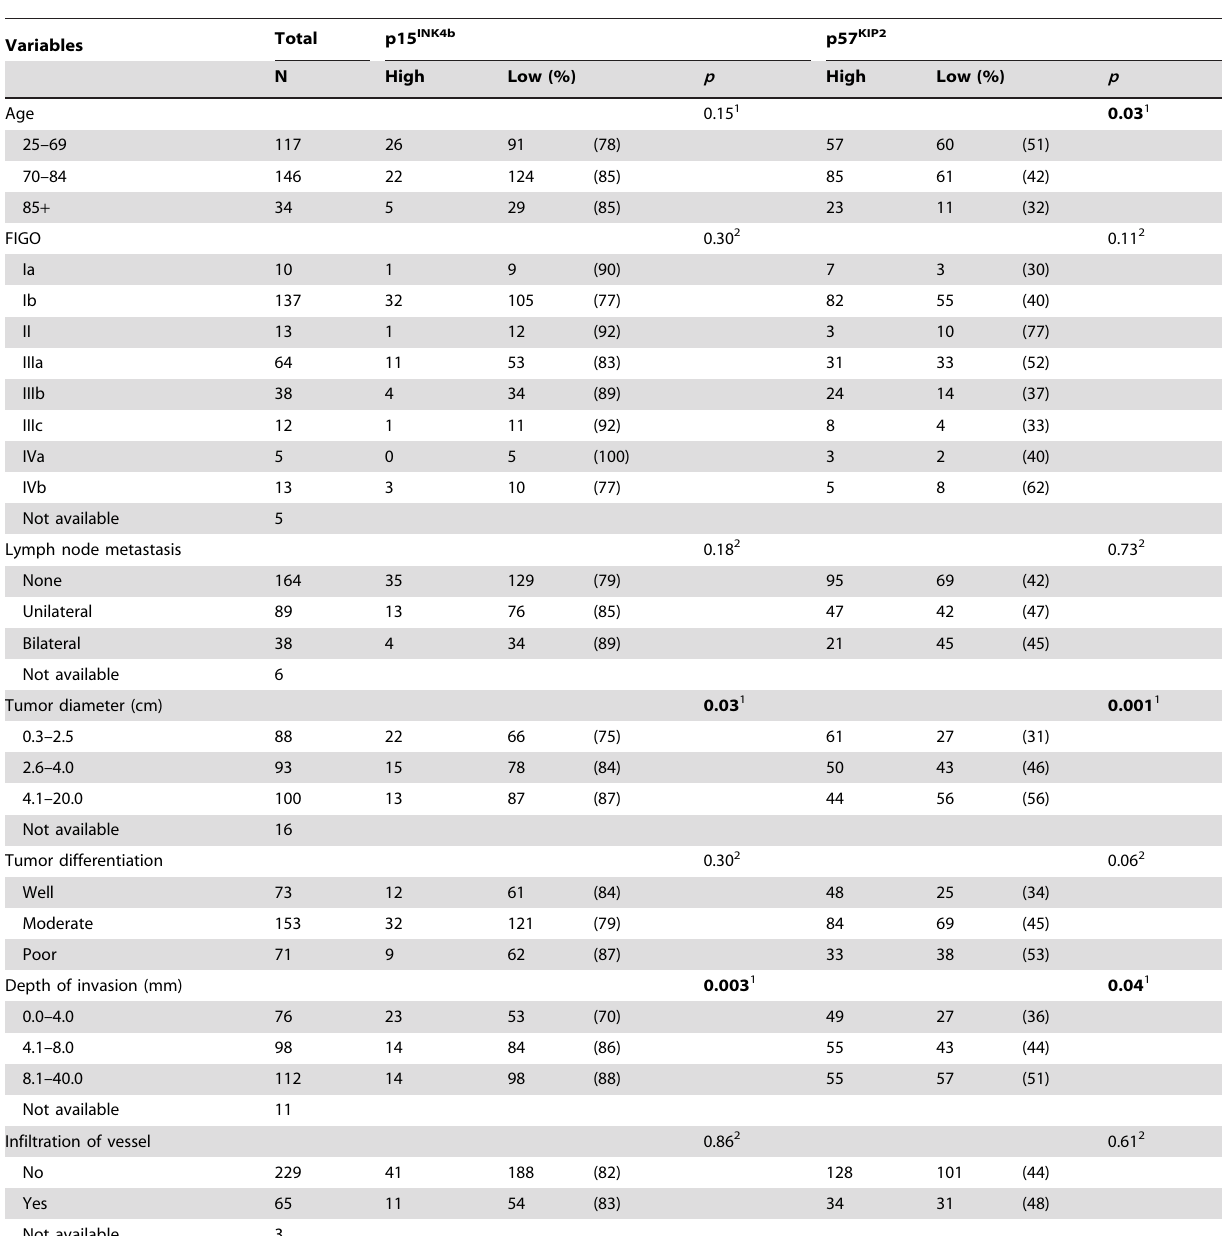
Table 2. p15 INK4b and p57 KIP2 expression in relation to clinicopathological